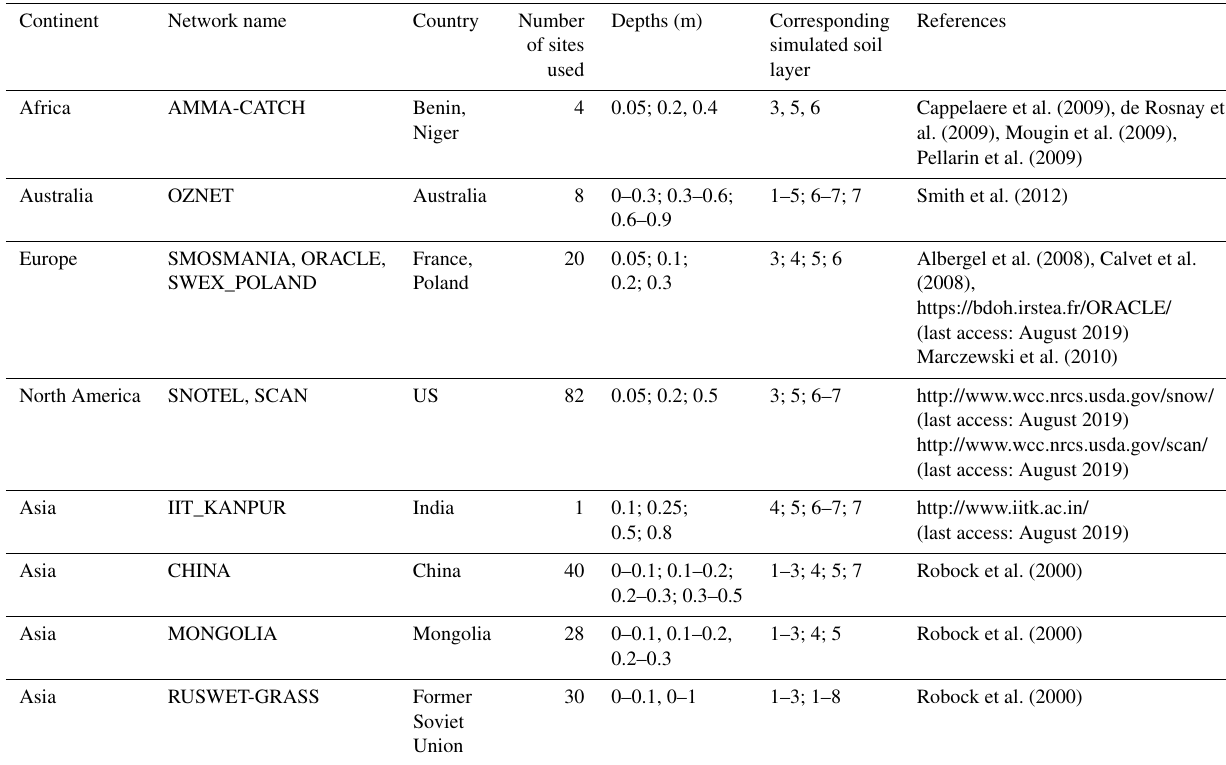
Table 2. Details for the stations used in this study.